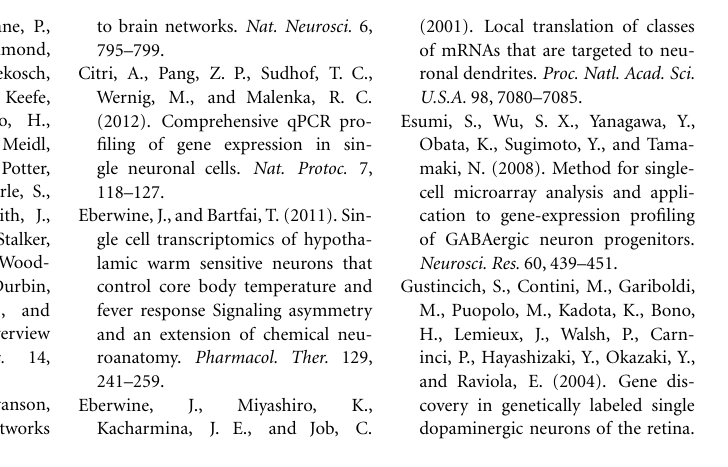
neurons in the same brain slice or different cells in the same neuronal culture. These data suggest that a large portion of the observed differences in gene expression are due to cell-to-cell phenotypic variability rather than noise due to technical